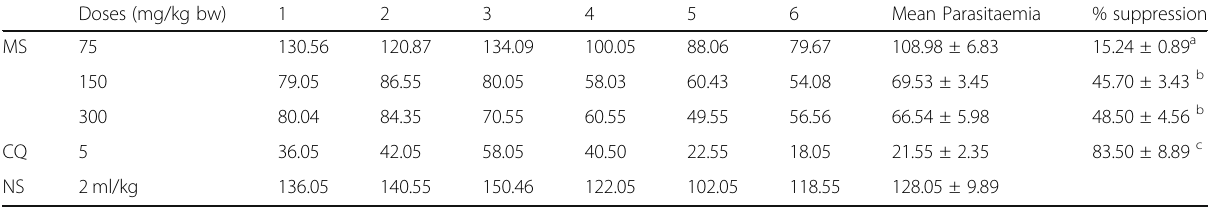
Table 1 Antiplasmodial activity of purified fraction of M senegalensis leaf against Plasmodium chabaudi Infected mice Doses (mg/kg bw)